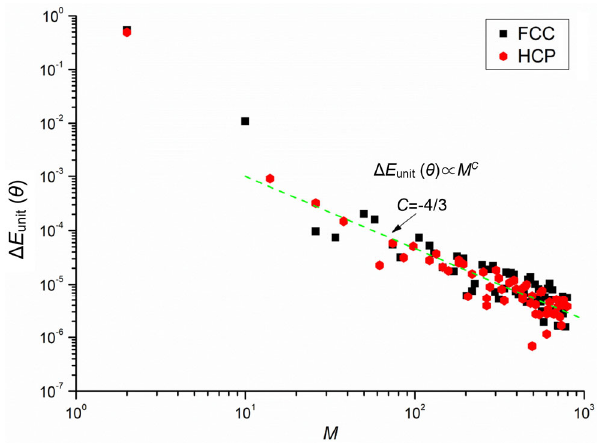
Fig. 3 Δ E unit ( θ ) versus M of commensurate systems with a single unit cell. Δ E unit ( θ ) is the corrugation of per-atom potential energy and M is number of atoms in contact area. Various sizes of commensurate systems with a single unit cell (the details are listed in Table S1 in the ESM) are calculated. Evidently, there is a linear relationship in double logarithmic plots, which means Δ E unit ( θ )  N C